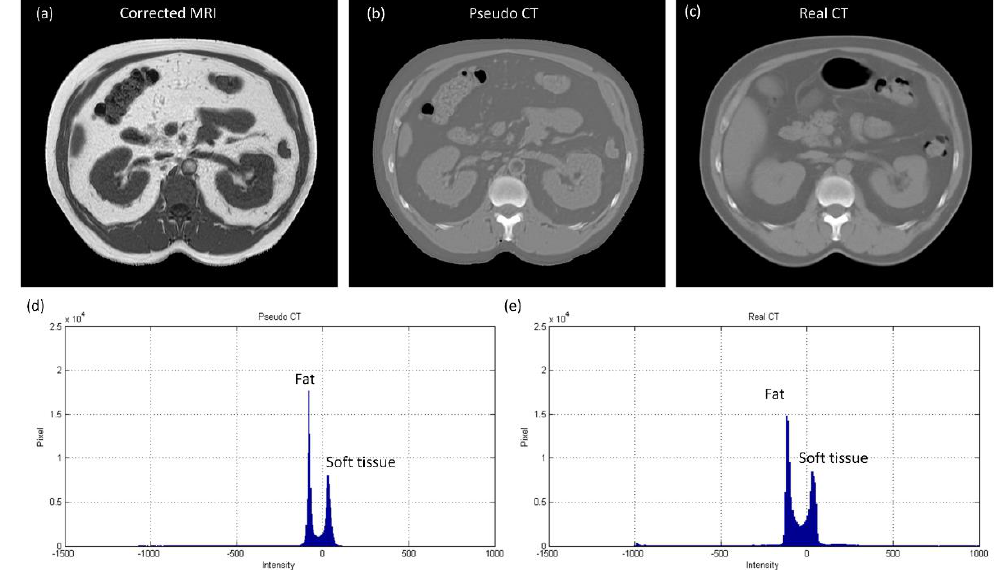
Figure 11. ( a ) Corrected MRI from 1.5 T scanner (WL/WW = 125/250), ( b ) pseudo-CT (WL/WW = 0/1000), ( c ) real CT (WL/WW = 0/1000), ( d ) histogram of pseudo-CT, and ( e ) histogram of real CT for abdominal imaging belonging to CNN testing dataset ( IMG testingabdomen ).